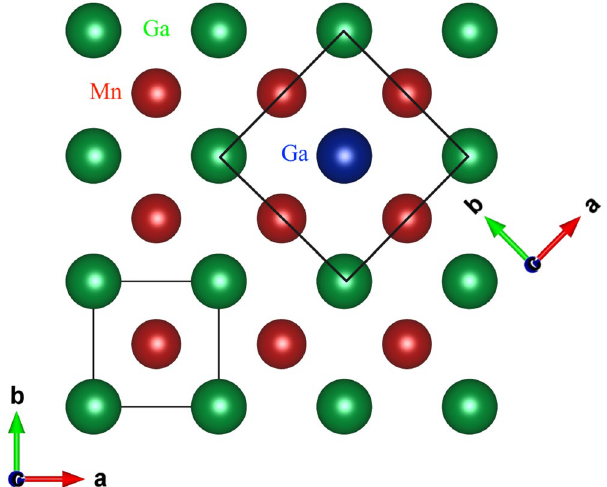
Figure 4. The basal planes for the small (bottom left) and large (top right) P4/ mmm cells showing the relationship between the a -axes in the two cases. The smaller-cell P4/ mmm basal plane is rotated by 45° and reduced in size by a factor of 2 with respect to the large-cell P4/ mmm basal plane. See Fig. 1 for views perpendicular to the c -axis.